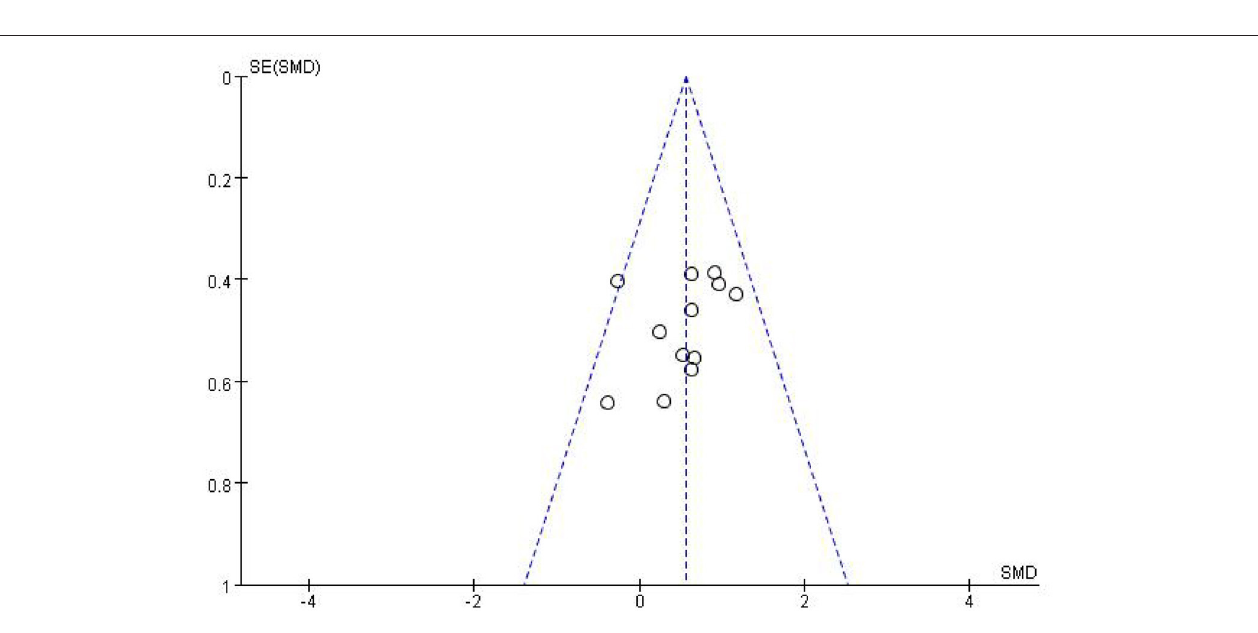
FIGURE 7 | Funnel plot of comparison of the effects of BCI interventions and control interventions on upper limb dysfunction after sensitivity